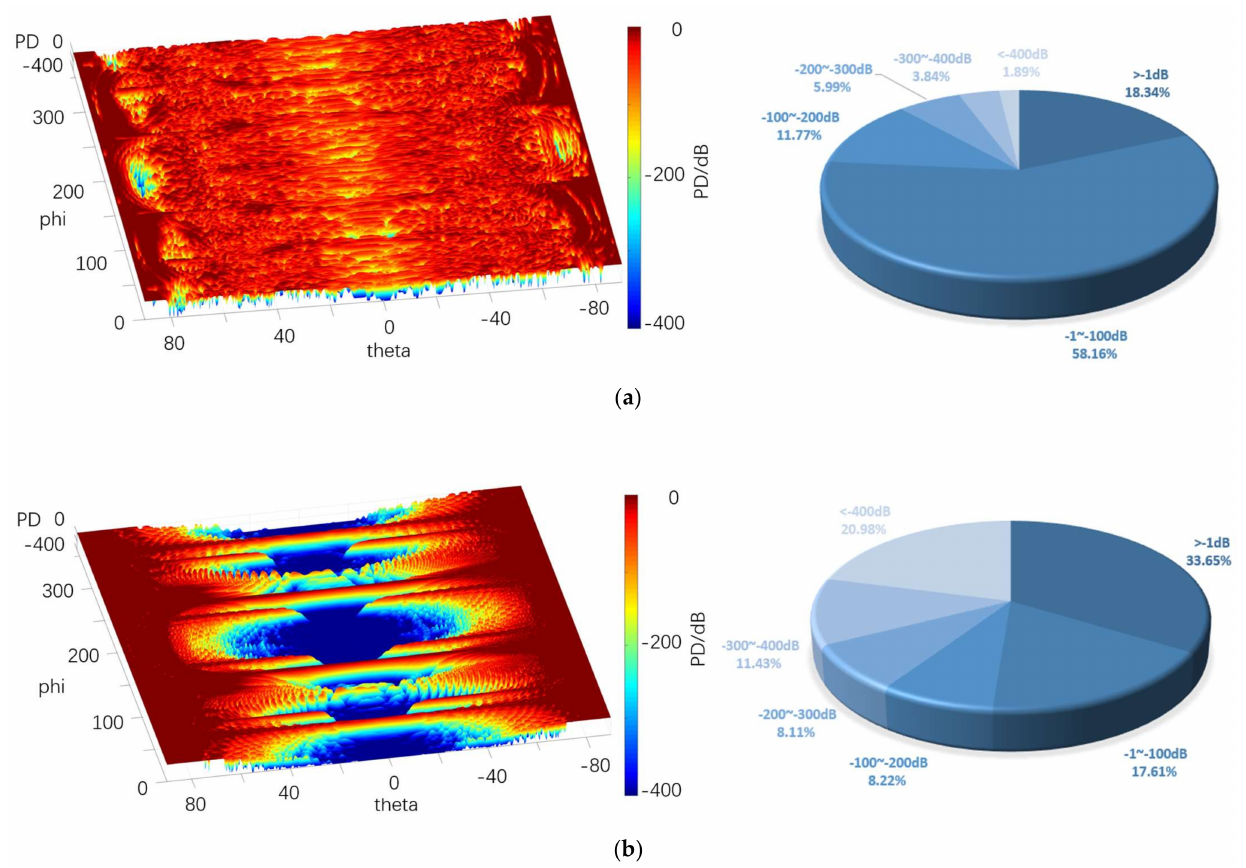
Figure 25. Probability distribution in the 4 π direction of 7.3 m 2 . ( a ) Quantum detection probability, ( b ) Probability of conventional